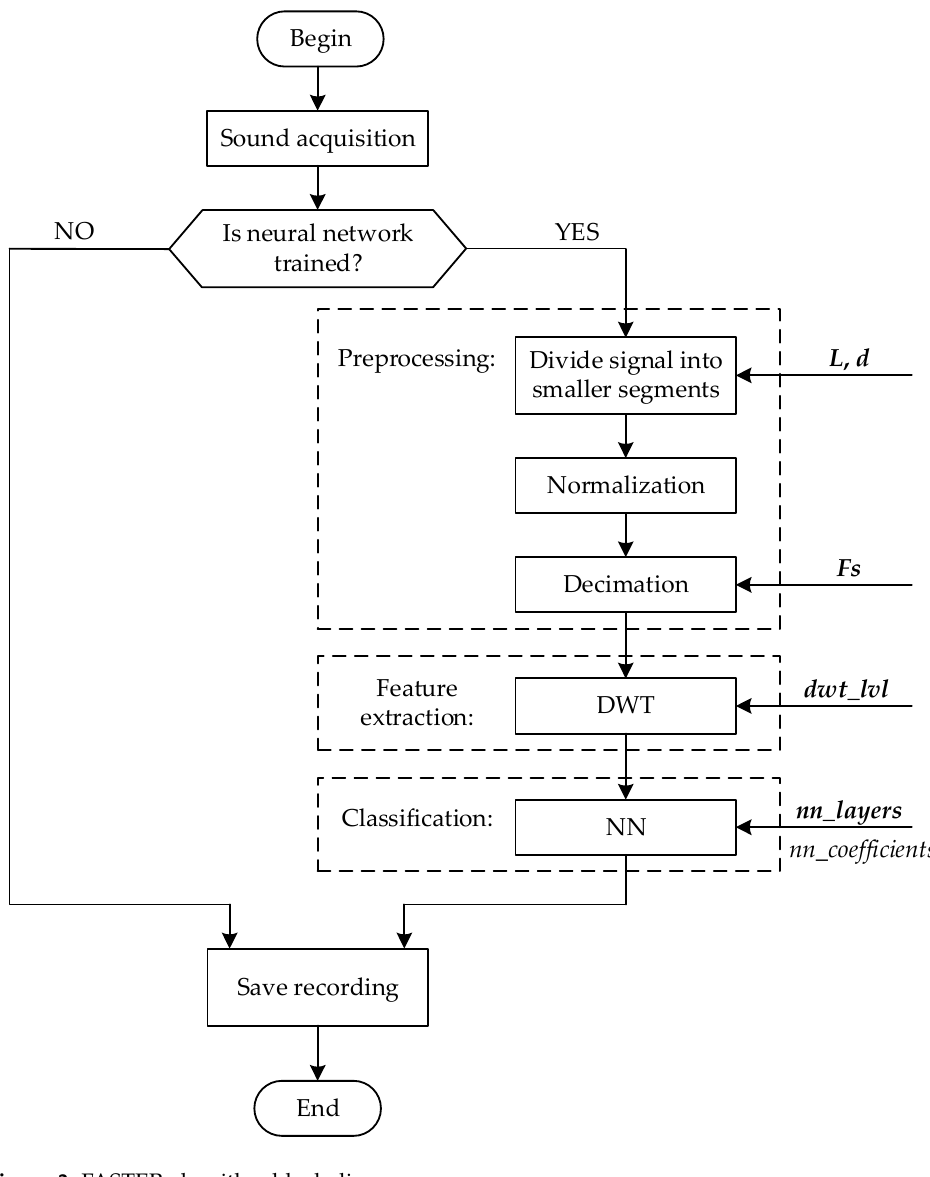
Figure 3. FASTER algorithm block diagram.